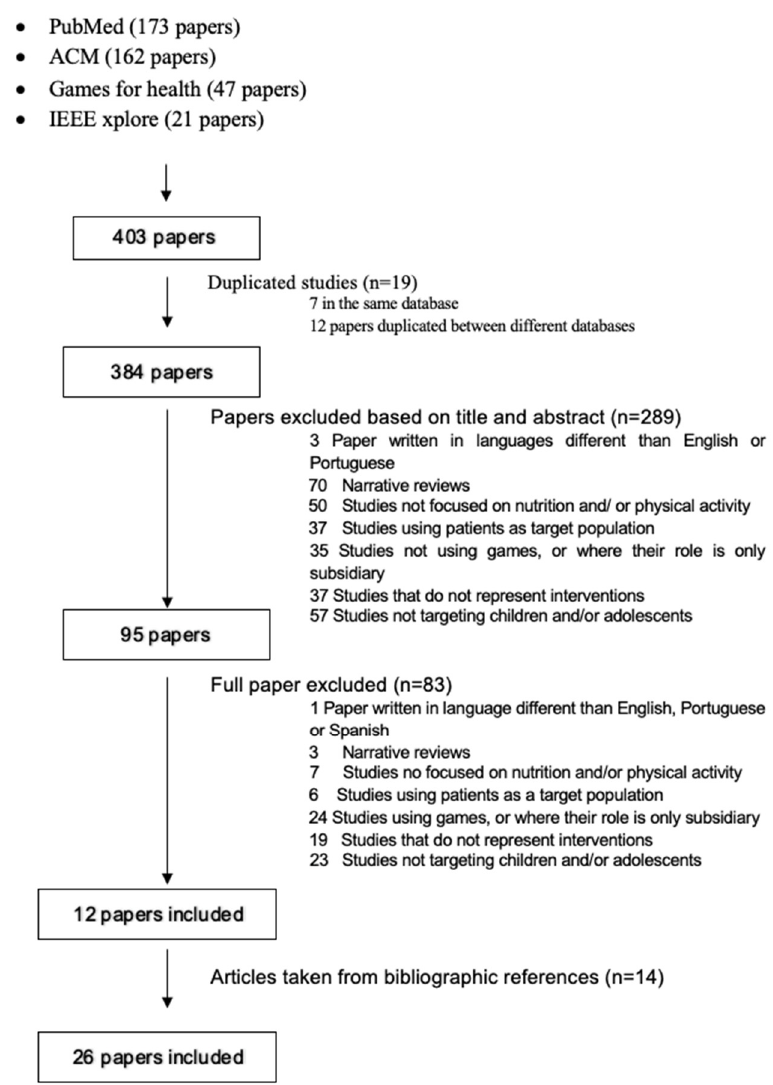
Figure 1. PRISMA diagram showing the screening process.